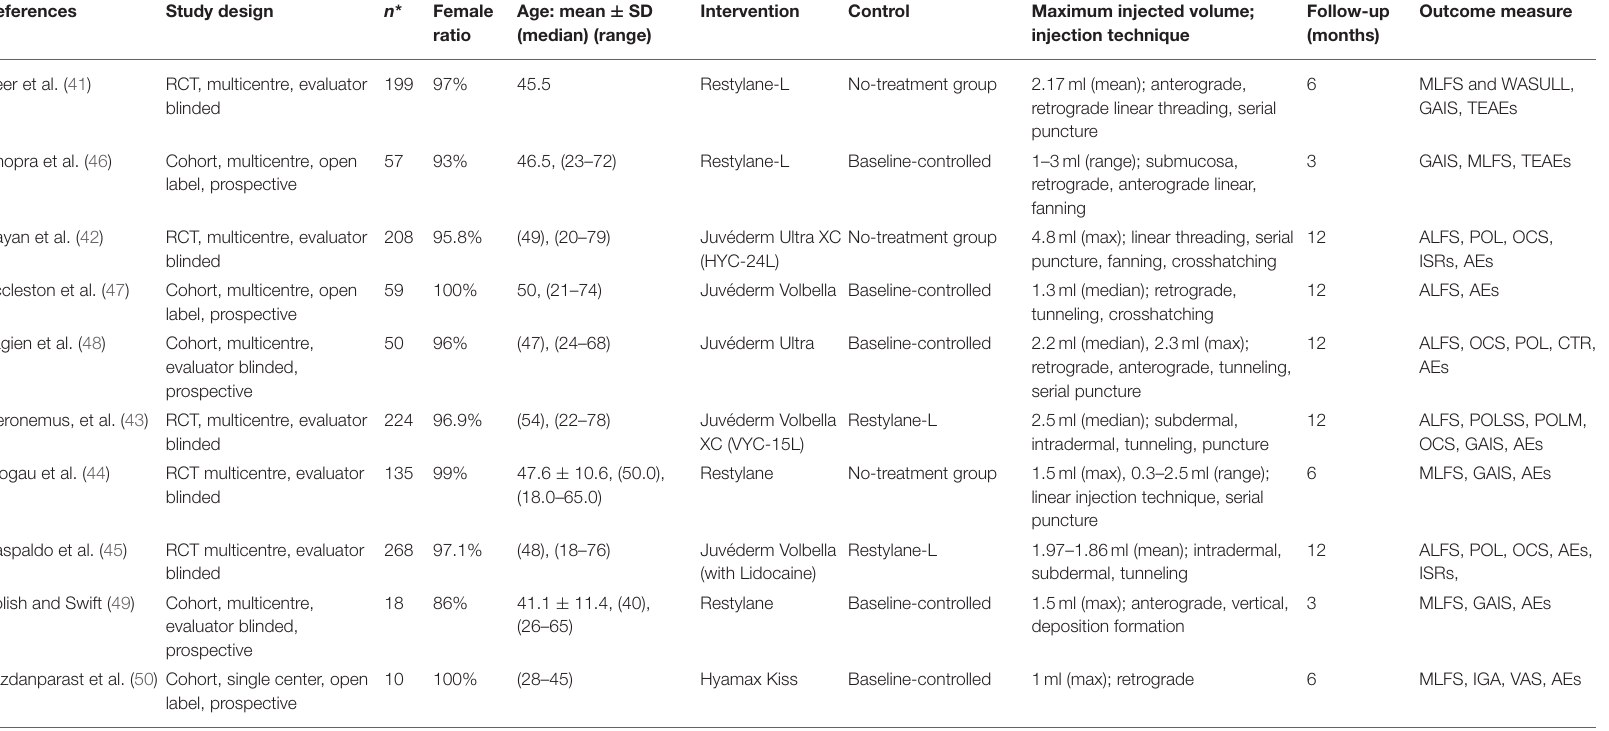
TABLE 1 | Study characteristics of records included in effectiveness